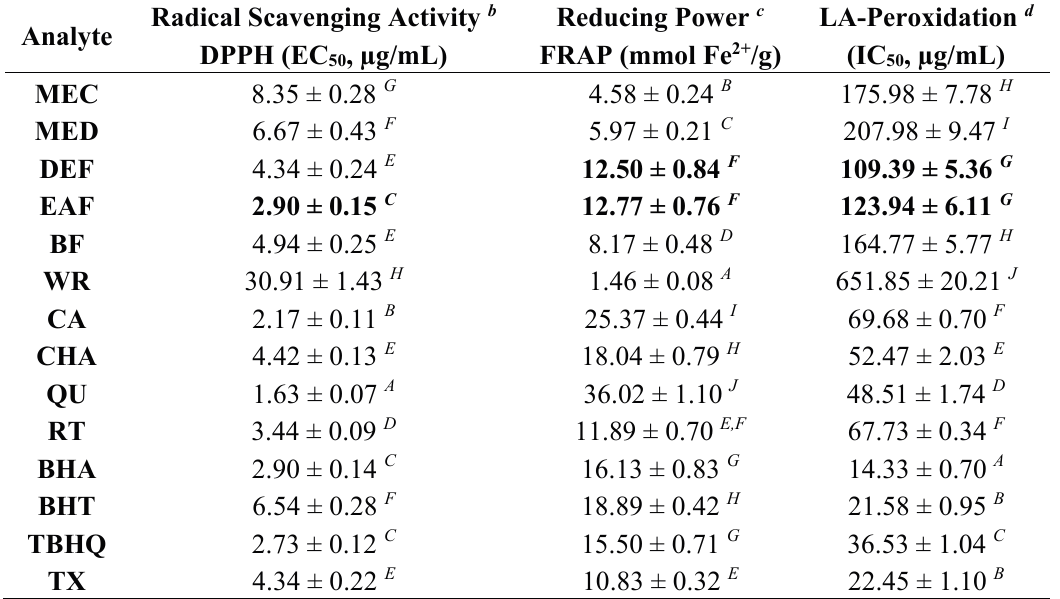
Table 1. Comparison of antioxidant activity of G. procumbens dry leaf extracts and standard antioxidants in DPPH, FRAP and inhibition of linoleic acid peroxidation tests a .